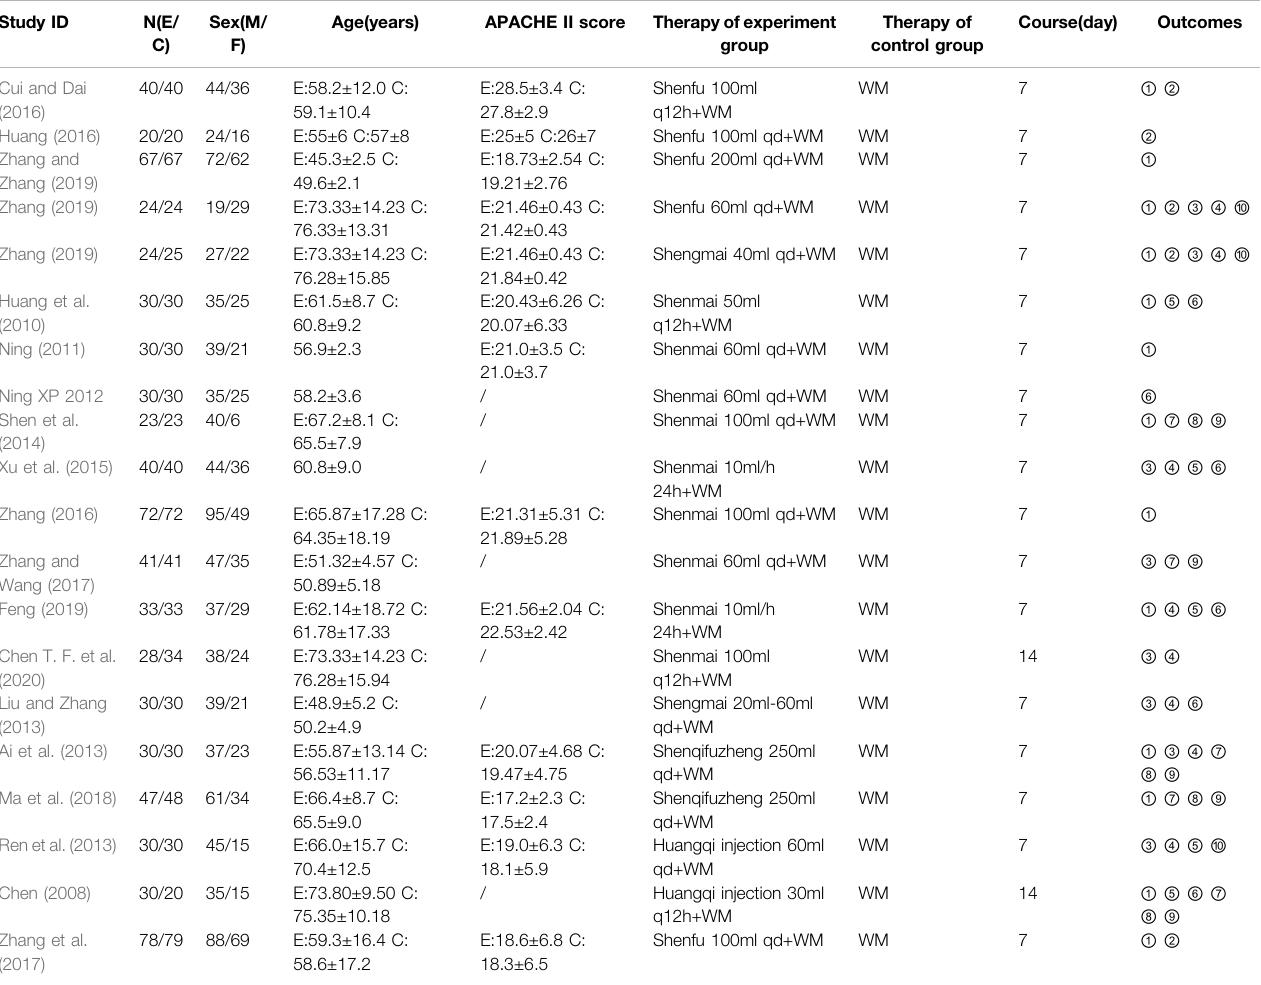
according to Table 4 . Treatments ranking based on SUCRA values, which were shown in Figure 4 and Table 11 , from largest to smallest, were as follows: Shenmai (94.4%), WM (17.4%) and Huangqi (13.8%). Node splitting method results and funnel plot were shown in Supplementary Table S3 and Figure 5 .